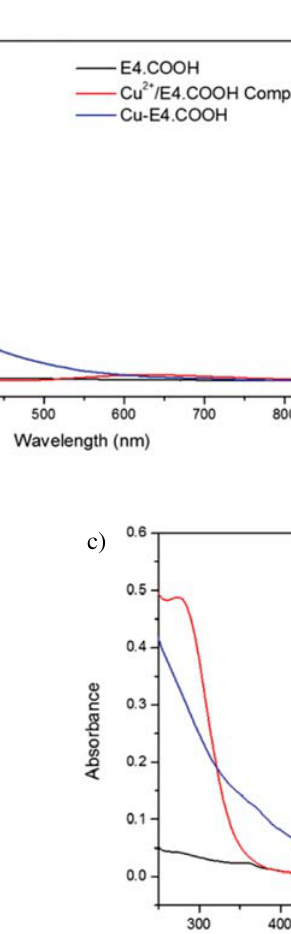
The absence of this band indicates that Cu clusters within the dendrimer cavity are smaller than 5 nm. 10 Results of the UV characterizations are in good agreement with the previously reported Cu-DENs.